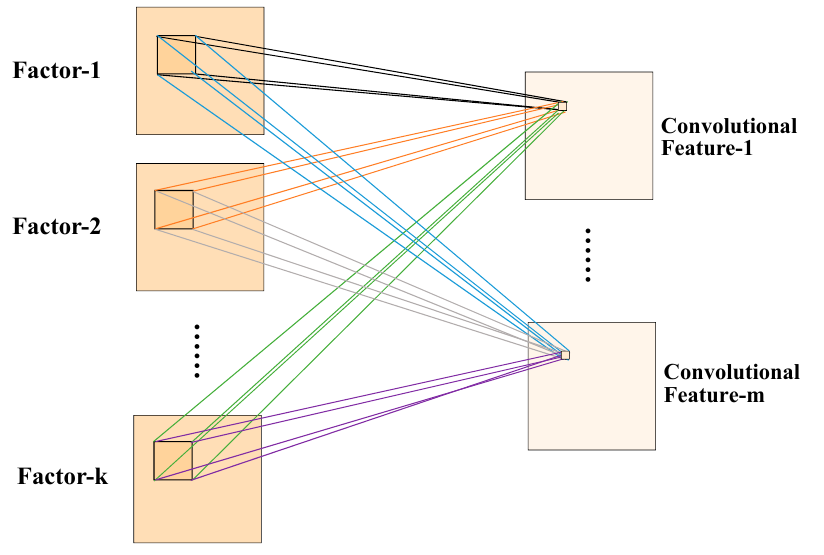
Figure 2. The illustration of 3-D convolution with m (m = 1, 2, . . . ) filters and k (k = 1, 2, . . . ) Figure 2 . The illustration of 3-D convolution with m (m=1,2,…) filters and k (k=1,2,…) convolution kernels, the convolution kernels, the weights are weights are color-coded.